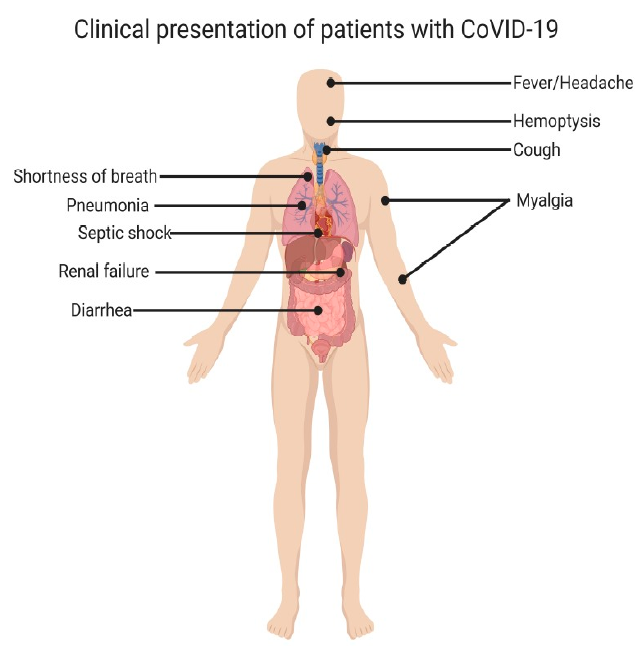
Figure 2. Clinical symptoms of COVID-19 patients (adopted from [15]).